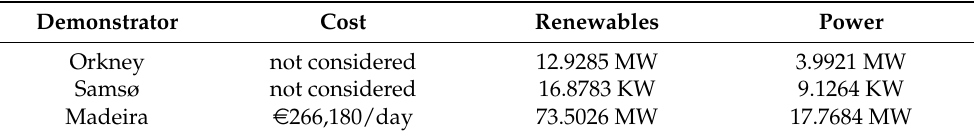
Table 4. Unstandardized values of the optimization KPIs for standardized values equal to 1. Re- garding Madeira cost, the unstandardized KPI is proportional to the standardized one. The un- standardized renewables and power stability KPIs are proportional to the square of the respective standardized ones. Demonstrator